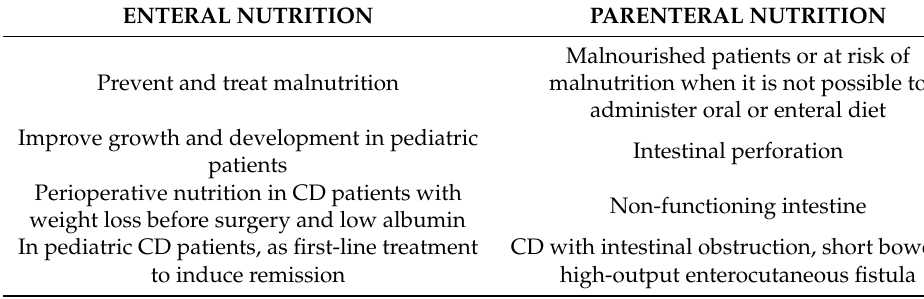
Table 4. Indications for enteral and parenteral nutrition in IBD patients. ENTERAL NUTRITION PARENTERAL NUTRITION Malnourished patients or at risk Prevent and treat malnutrition